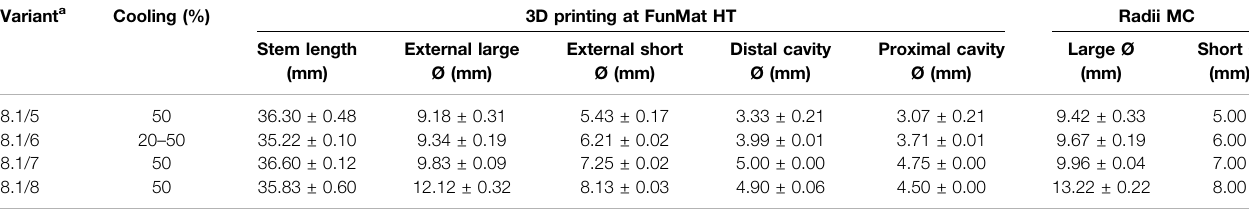
TABLE 8 | 3D-printed (FunMat) radii PEEK plug variants and radii medullary cavity (MC) dimensions, and different cooling values.